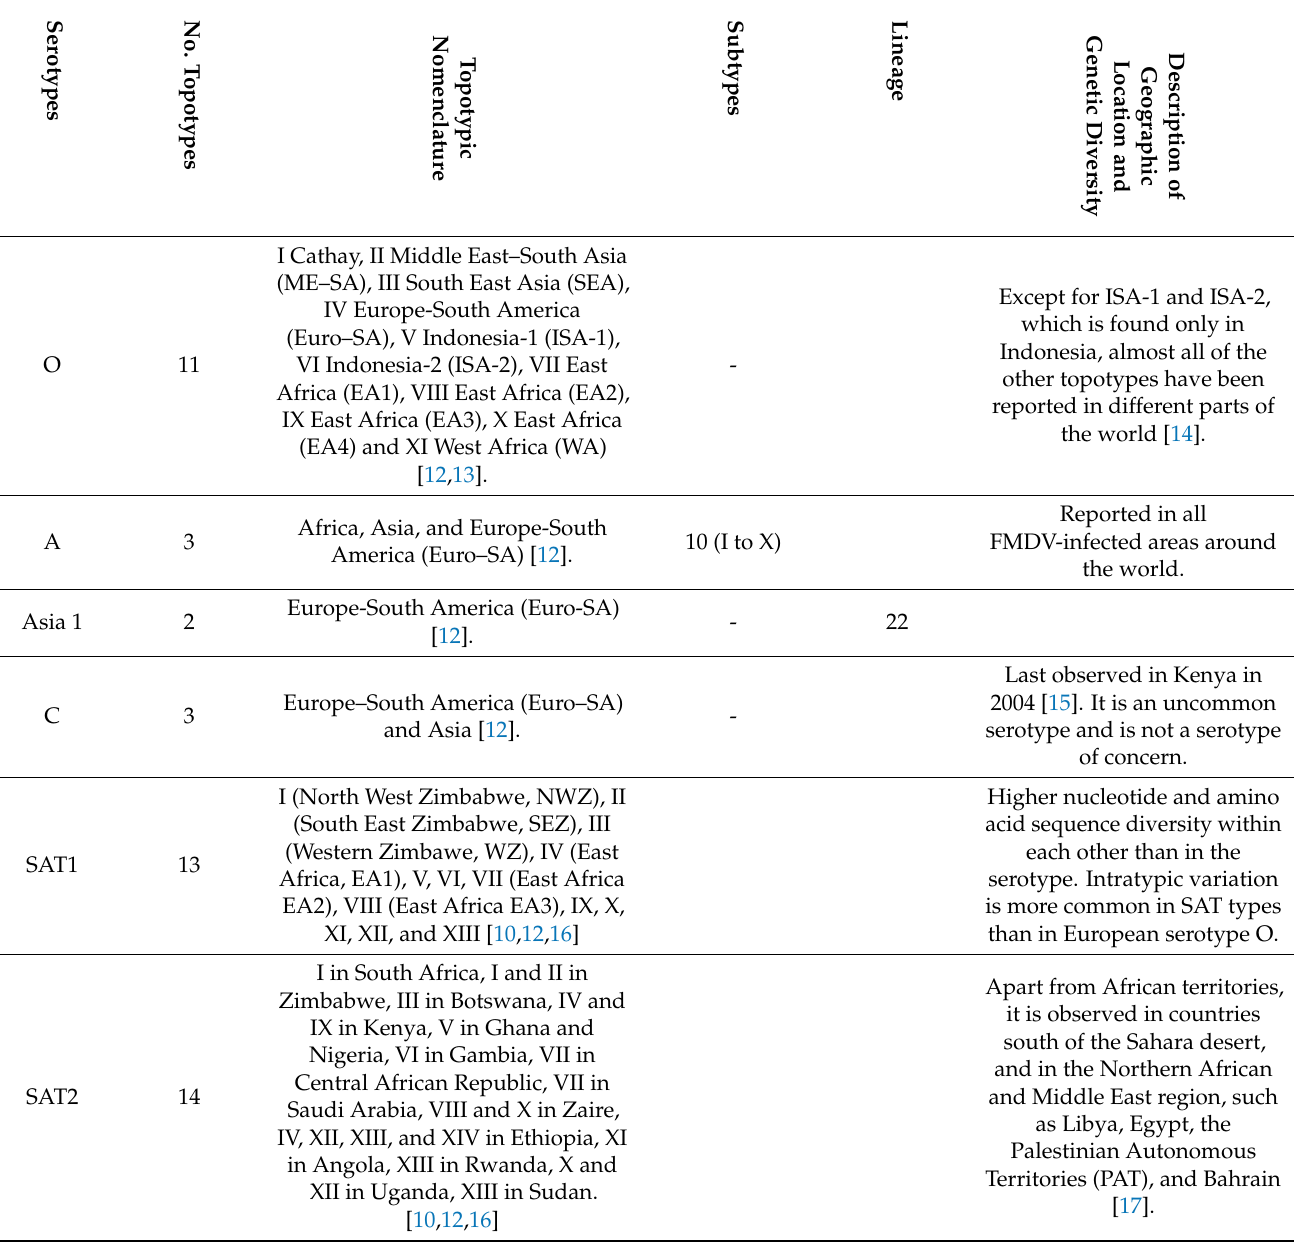
Table 1. Summary of the serotypes, subtypes, lineages, and topotypes of